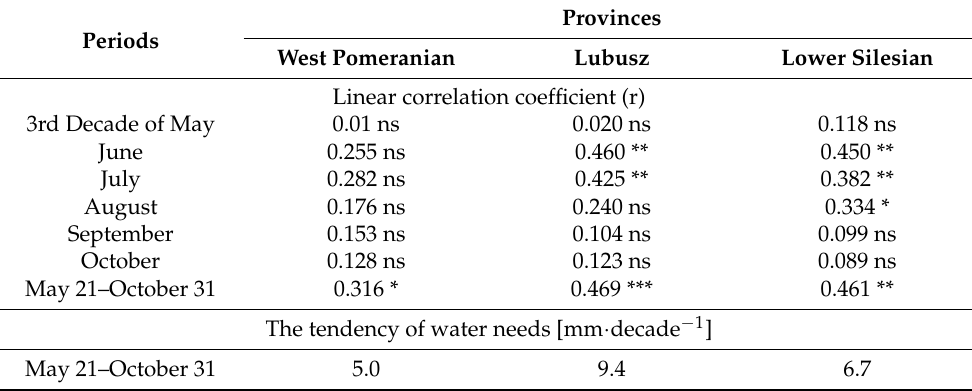
Table 6. Water needs (mm) of willow in the years between 1981 and 2010 in the provinces of western Poland. Provinces Periods West Pomeranian Lubusz Lower Silesian Linear correlation coefficient (r) 3rd Decade of May 0.01 ns 0.020 ns 0.118 ns June 0.255